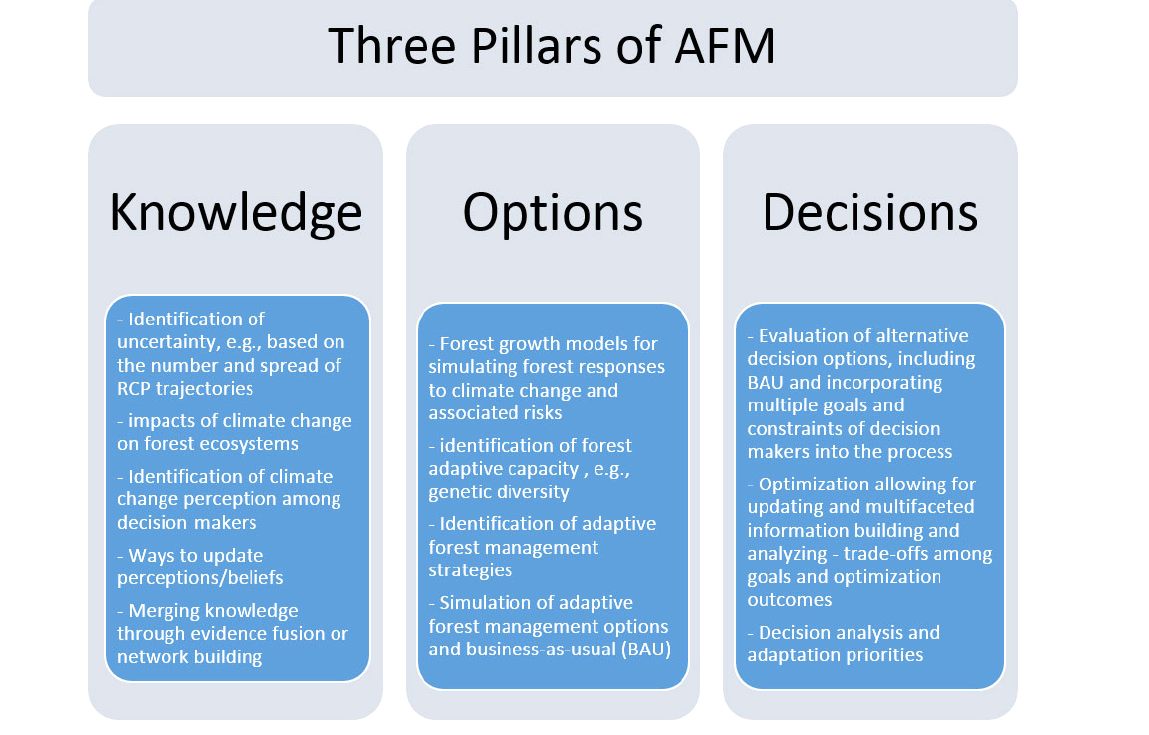
Fig. 2 . Three pillars of the suggested framework for addressing adaptive forest management (AFM) under climate change uncertainty. RCPs are four greenhouse gas concentration (not emissions) trajectories adopted by the IPCC (2014) for its fifth Assessment